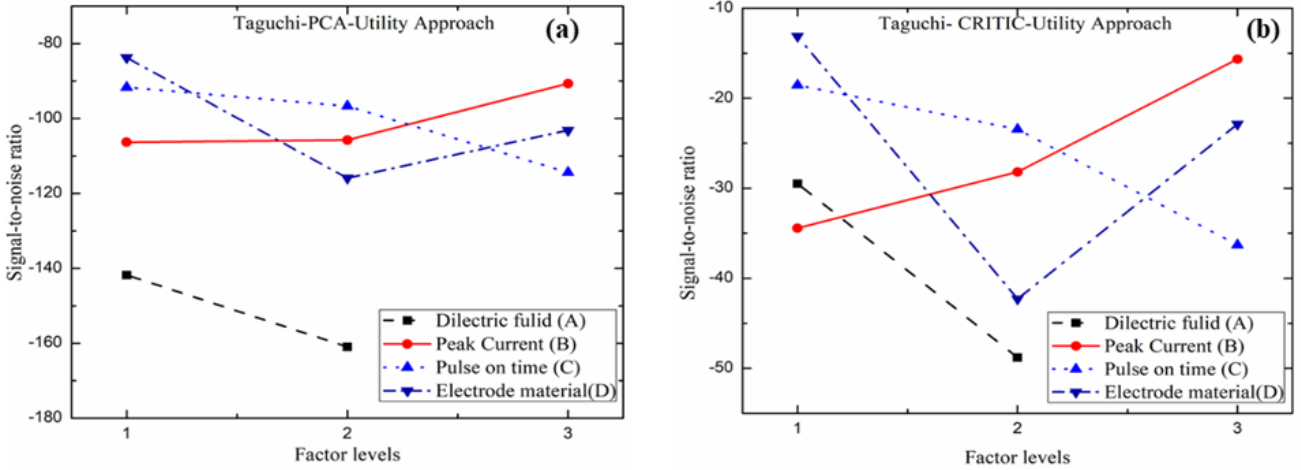
Figure 5. Main effect plots of multi-response: ( a ) Taguchi-PCA-Utility approach, ( b ) Taguchi-CRITIC-Utility approach.